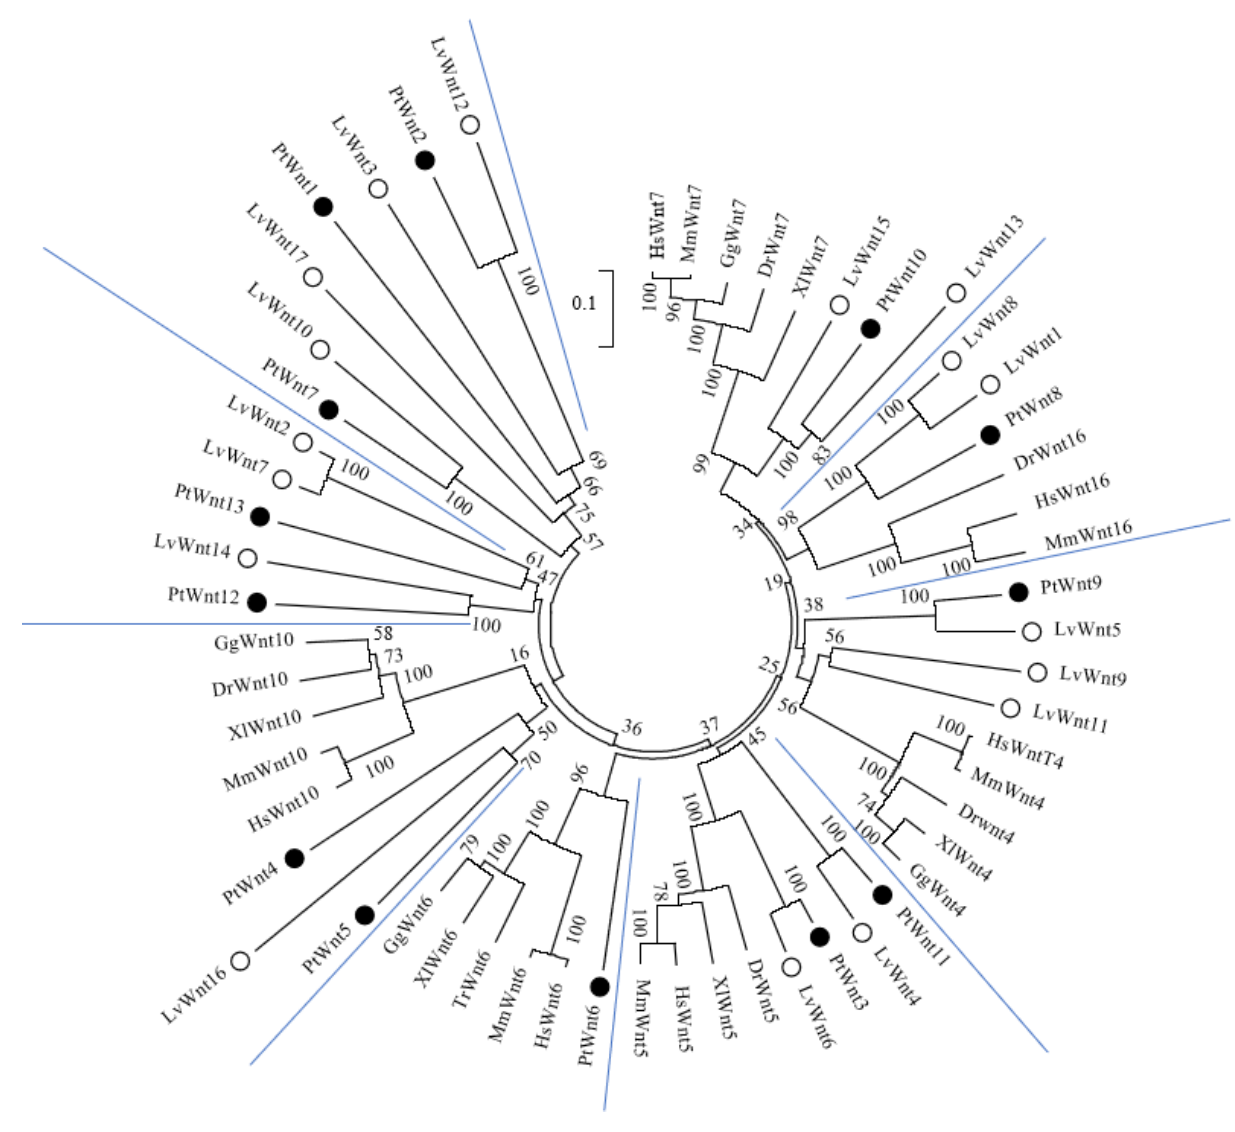
Figure 2. Phylogenetic analysis of PtWnt and LvWnt proteins. The ● represent P. trituberculatus ,